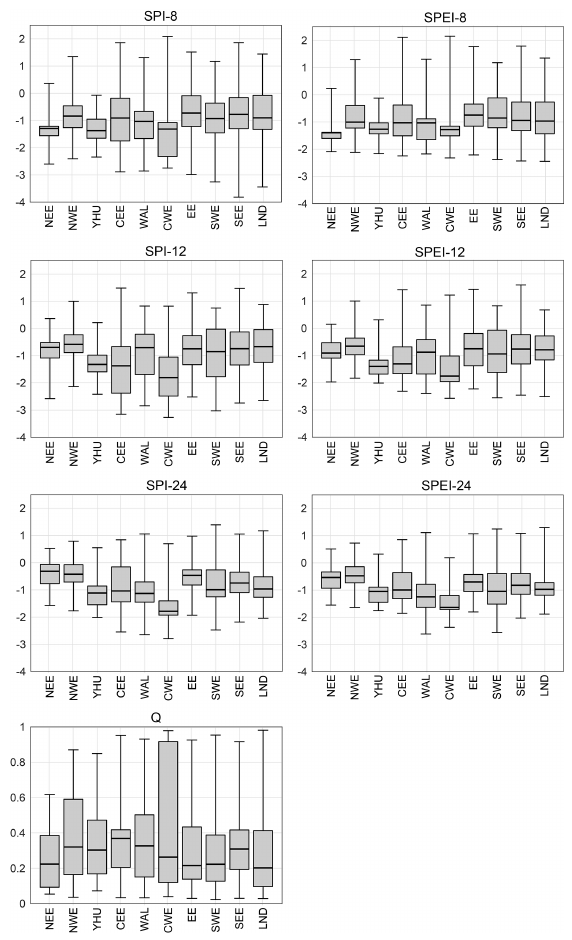
Figure 8. UK: distribution of splitting values during random for- est construction (i.e., thresholds of impact occurrence) for selected drought indicator variables for each NUTS1 region. The box plot whiskers extend to the minimum and the maximum of the distribu- tion, the box encompasses the interquartile range, and the line inside the box displays the